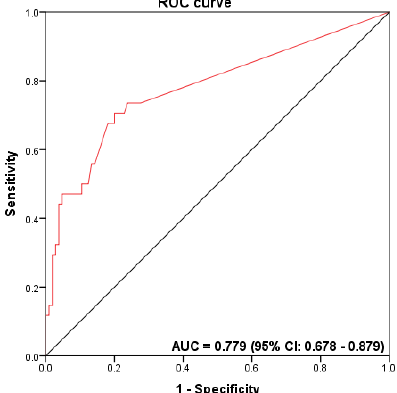
Figure 3. Receiver operator characteristic (ROC) curves to assess the discriminatory accuracy of Fn DNA detection by ddPCR. 3.5. Association between Fn Status and Patients’ Clinical -Pathological and Molecular Features The association of Fn score detection by ddPCR and qPCR with patients’ clinico-